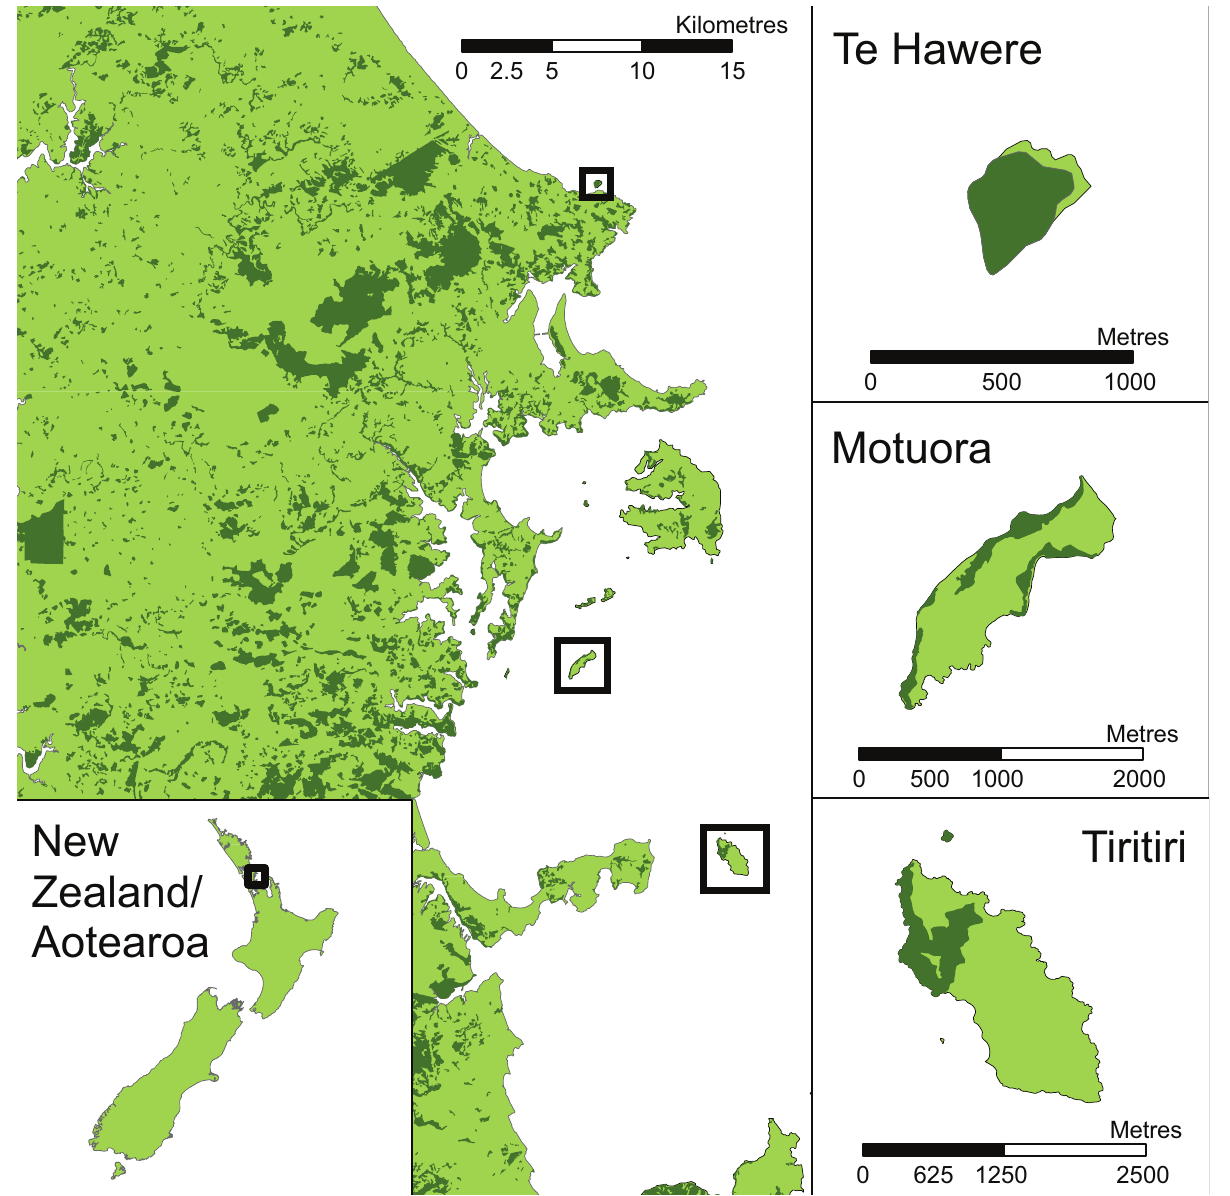
Figure 1. North Auckland, New Zealand, with study islands